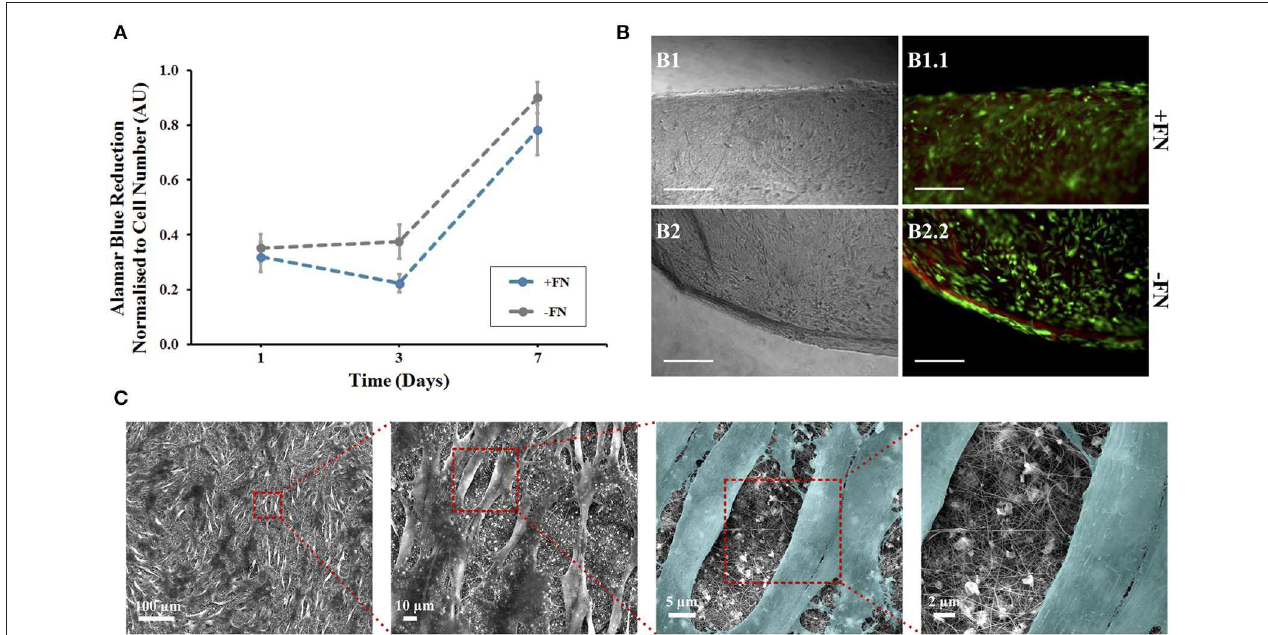
FIGURE 2 | Human mesenchymal stem cells on composite electrospun nanofibres. Cells were cultured on nanofibrous discs in the presence of 5ng/ml FGF-2 with (blue line) and without (gray line) fibronectin (FN) coating. (A) Viability at 1, 3, and 7 days using Alamar Blue assay, data points show mean ± SE. (B) A LIVE/DEAD viability assay was performed at day 7. Optical (B1,B2) and fluorescence (B1.1,B2.2) microscopy images of cells on composite nanofibres. Live and dead cells show green and red fluorescence, respectively. Scale bar inset measures 300nm. (C) Samples were then fixed and viewed using scanning electron microscopy. Cells were colored in latter images to enhance contrast between cells and nanofibres ( n =